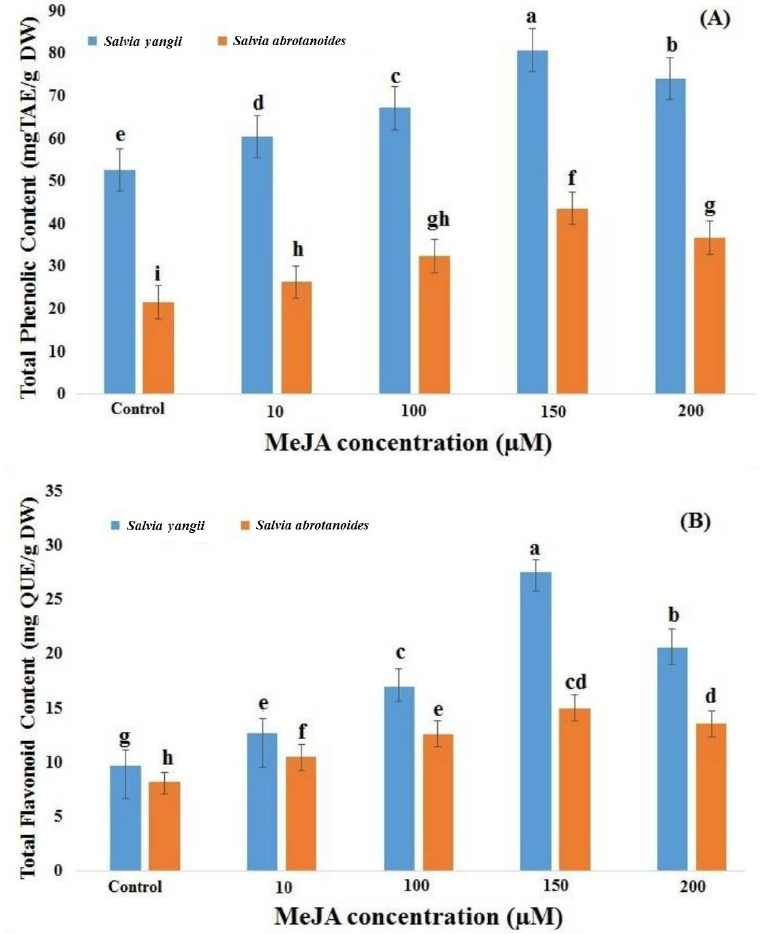
Figure 3. The effects of MeJA on TPC ( A ) and TFC ( B ) in two species of the genus Salvia , subgenus Perovskia Kar. Means and standard deviations ( n = 3) are shown for the data. Duncan’s test claims that if there are different letters in each column, then it is statistically significant at the 1% level. Error bars depict the standard error values . Means followed by the same letters in each column are not significantly different ( p < 0.01).